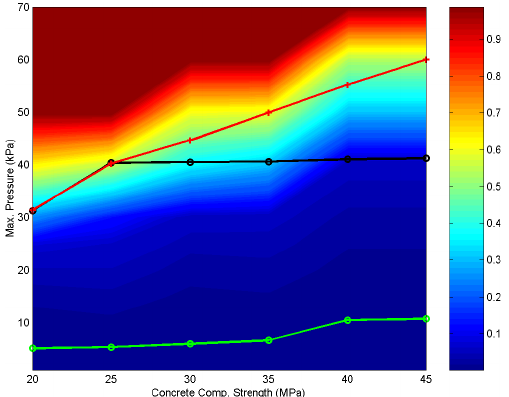
Fig. 17. Vulnerability function ( I D ) obtained for several values of maximum compressive strength ( σ c